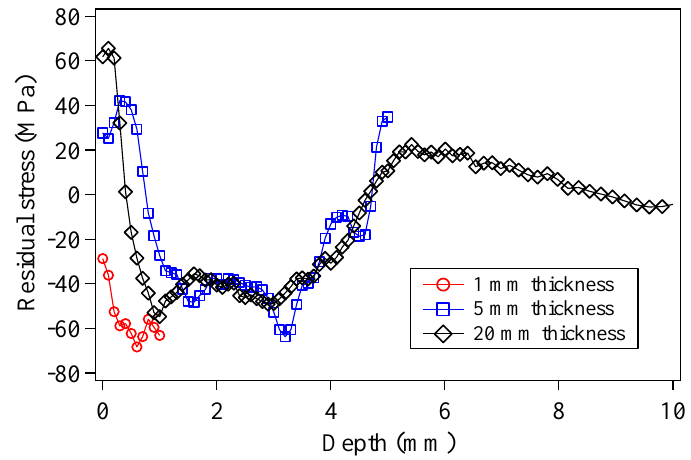
Figure 13. In-depth residual stresses of the LSPed targets with the different thicknesses. Figure 13. In − depth residual stresses of the LSPed targets with the different thicknesses. By utilizing the dislocation density-based constitutive model, both the increased dislocation density and the decreased cell size distributed along the Path-Z are presented in Figure 14. Correlating with the in-depth equivalent plastic strains, the significant increase in the dislocation density and the decrease in the cell size can be seen in Figure 14. When compared to the in-depth dislocation density and cell size resulting from the LSP of the target models with the thicknesses of 5 mm and 20 mm, in the case of LSP of the 1mm- thickness target model, owing to the multiple reflections of the LSP-induced shock wave, the dislocation density increases with the increase of the depth, and the cell size decreases with the depth correspondingly, and both the maximum dislocation density and the minimum cell size are located in the bottom surface of the target model. It thereby reveals that the reduction of the target thickness could increase the reflection times of LSP-induced shock wave, which would be conductive to the grain refinement induced by LSP.